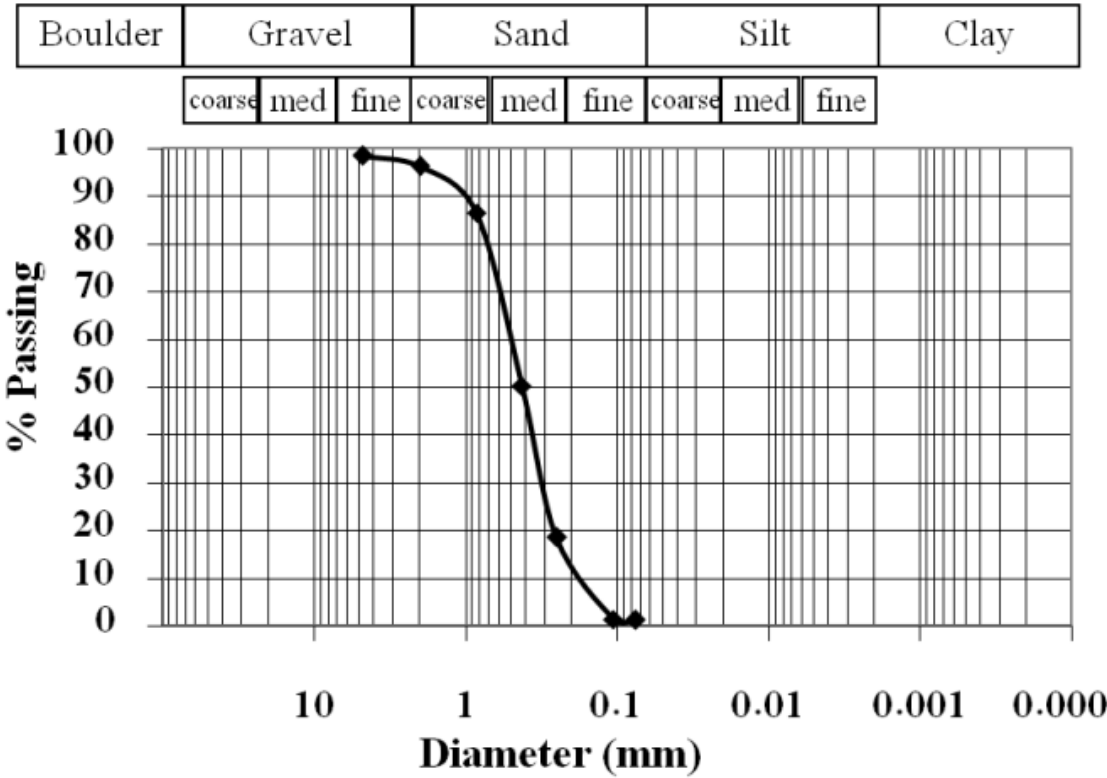
Figure 14. The sieve analysis of specimen 8 at 88.1E km at Sarapum